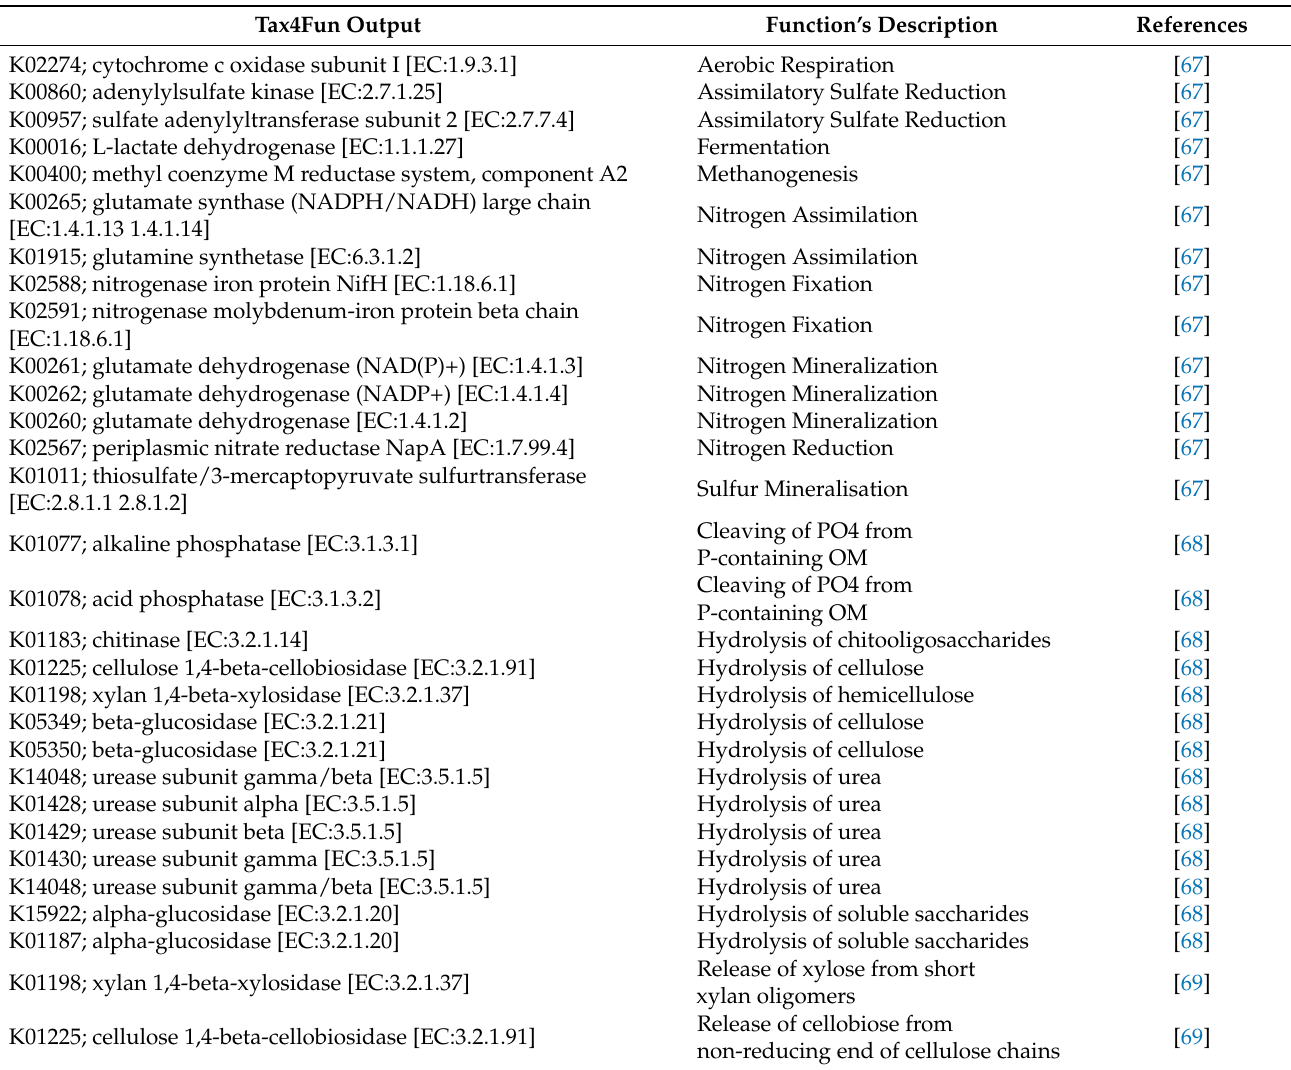
Table A1. Tax4Func functions involved in soil system and its